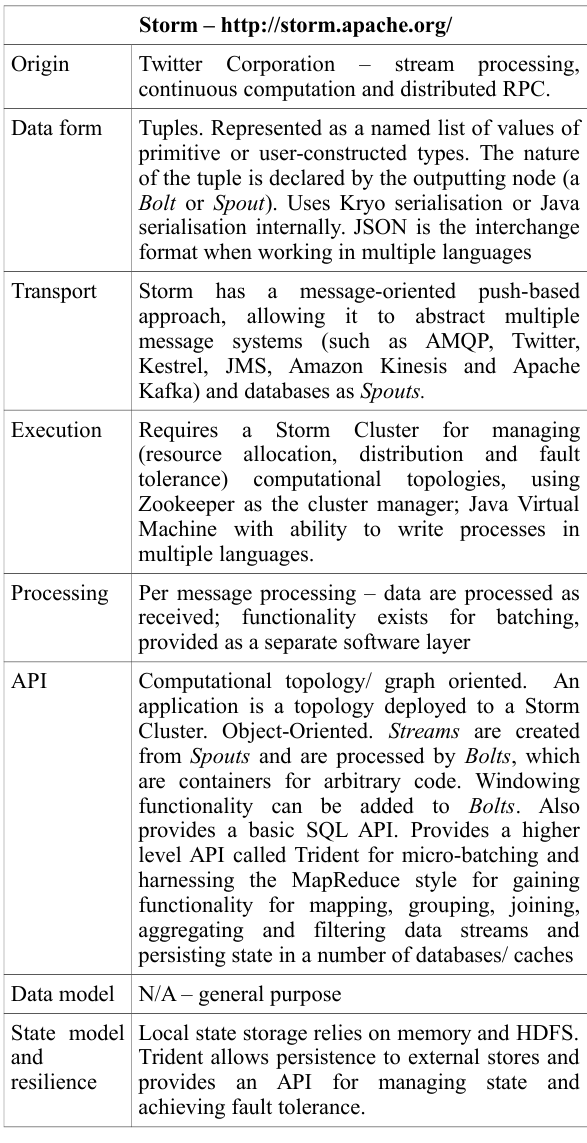
Table 1: Streaming Frameworks - Storm